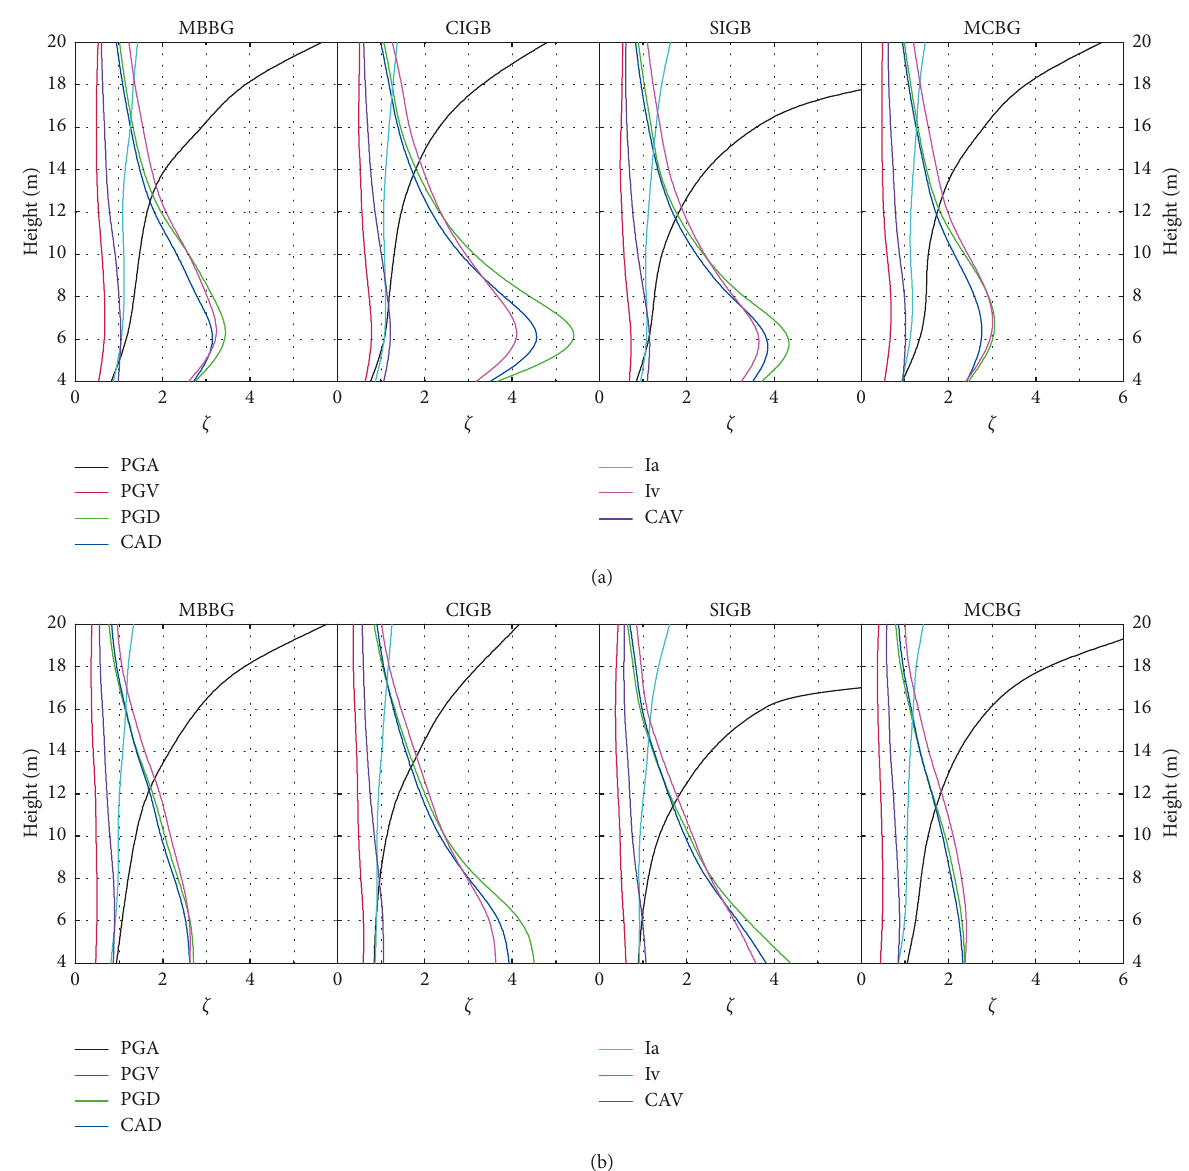
Figure 14: IMs proficiency comparison for (a) the pier curvature ductility along the longitudinal direction and (b) the pier curvature ductility along the transverse